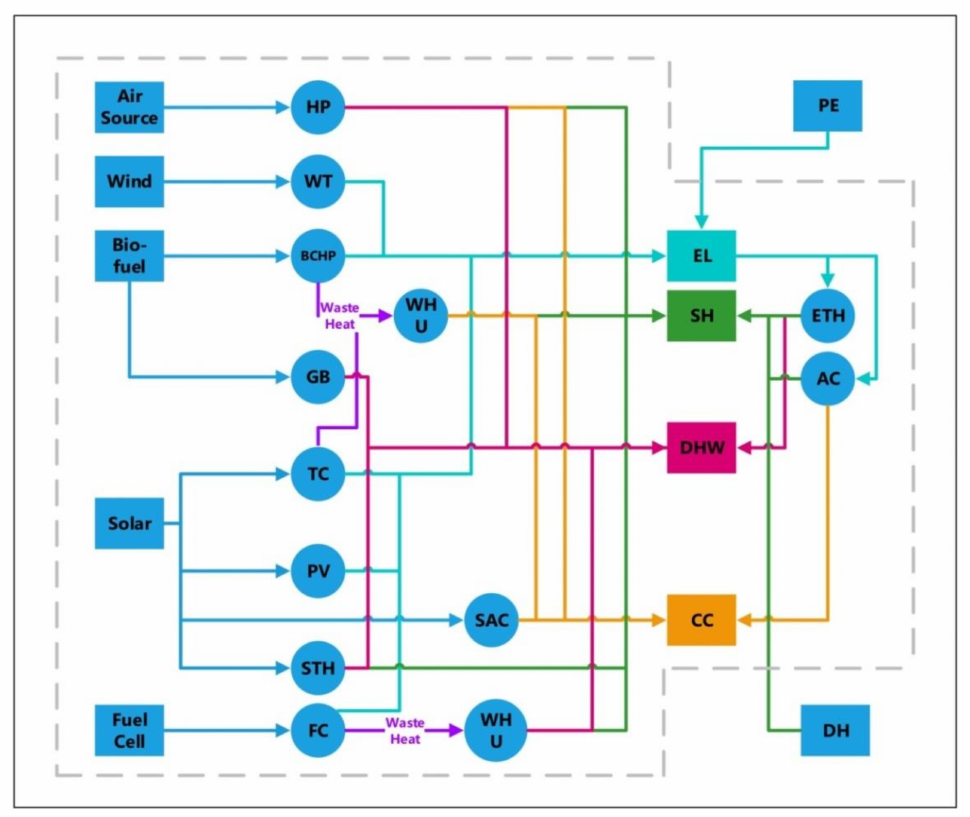
Figure 1. Example of MENR system. A demonstration of ideal MENR